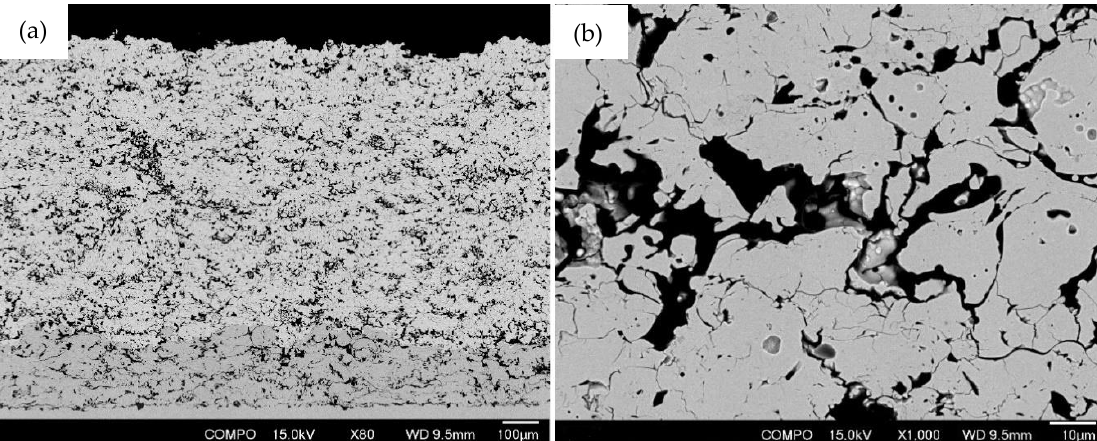
Figure 3. Microstructure cross-section of the coating produced with commercial powder and 100HE plasma system. Overall coating ( a ) and high-magnification images ( b ).